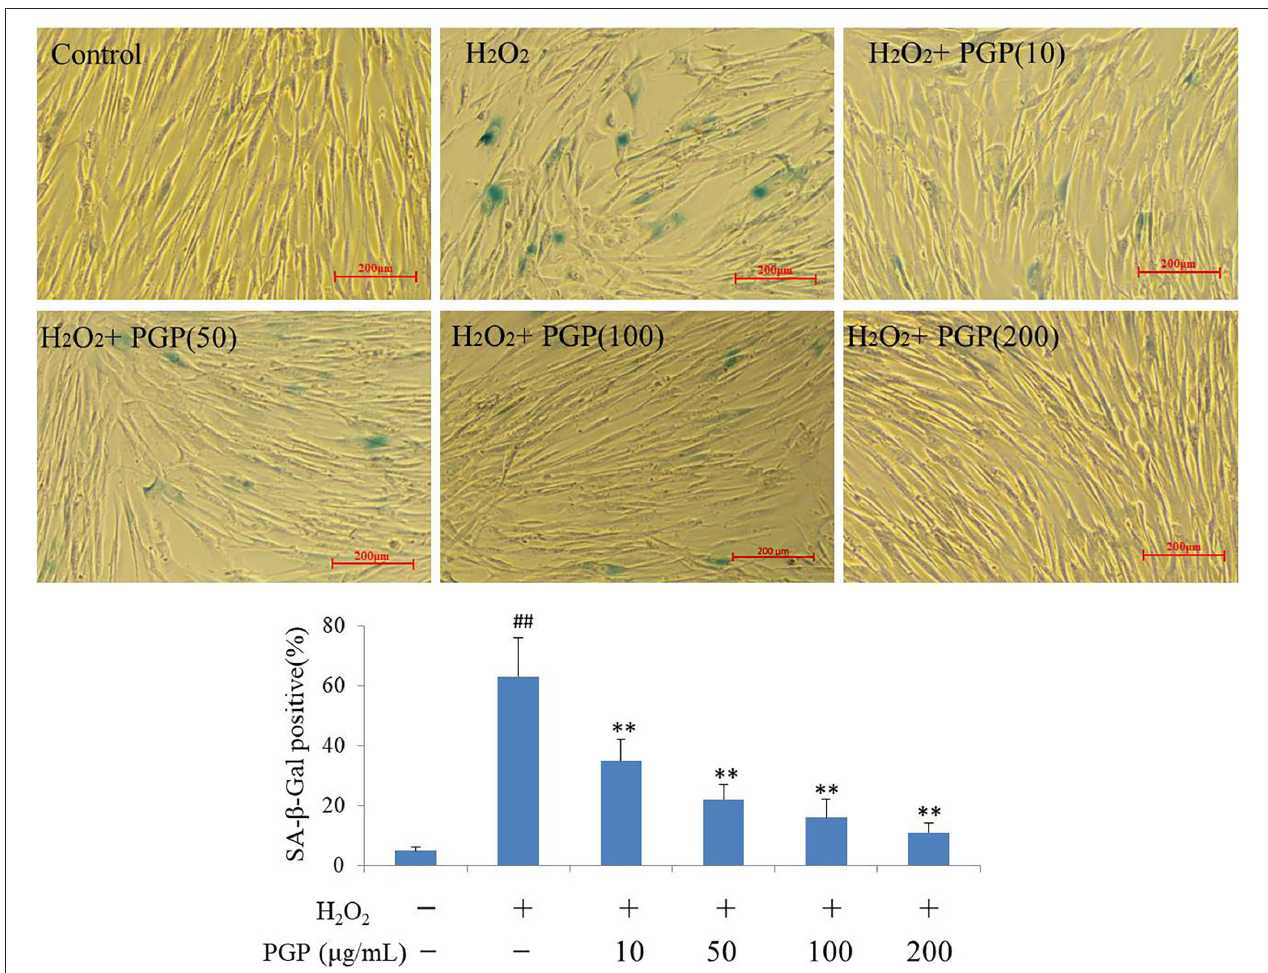
FIGURE 5 | The SA- β -Gal staining of young 2BS cells treated with H 2 O 2 followed by PGP (** p < 0.01 vs. H 2 O 2 alone group; ## p < 0.01 vs. control group). PD28 2BS cells were seeded in 24-well plates for 20h before quick exposure to H 2 O 2 as stated above. The cells were then incubated in fresh medium without or with PGP for additional 5 days. Cells were photographed at the magnification of 10 × . The percentage of SA- β -gal-positive cells out of the total cells was counted and the average data were obtained from three independent experiments.